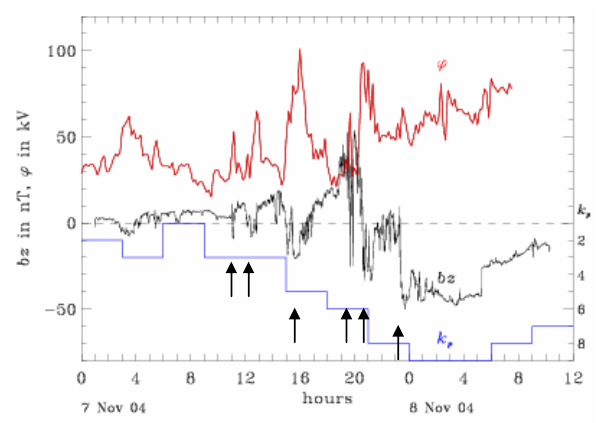
Fig. 1. Variation of (i) transpolar potential deduced from the Super- DARN flow observations in the ionosphere, (ii) K p index calculated from the ground-based magnetic records and (iii) south-north com- ponent, B z , of the interplanetary magnetic field measured on board the ACE satellite on 7 and 8 November 2004. Arrows indicate the southward rotation of the interplanetary magnetic field. Magnetic records in the solar wind are shifted by 1h.